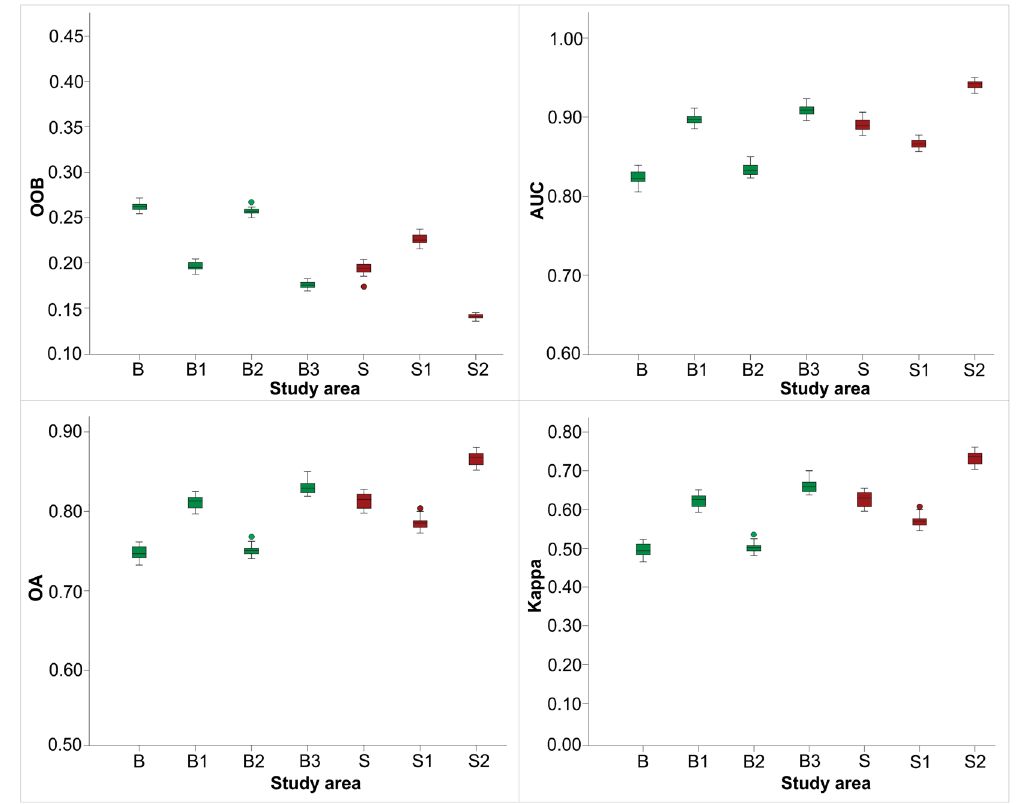
Figure 4. Distribution and variation of accuracy metrics after 20 repetitions. The Buzău study areas are shown in green; the Shizuoka study areas are shown in red. OOB out-of-bag error, AUC area under the curve, OA overall accuracy, Kappa kappa index of agreement.